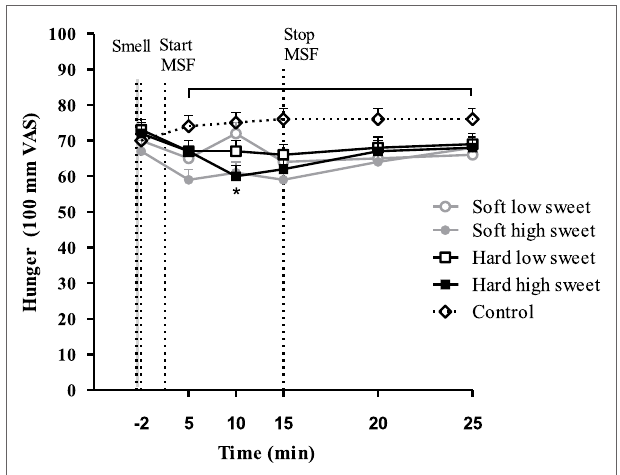
FigUre 12 | Estimated mean ± SEM post modified sham feeding (MSF) lunch intake (in grams) per model food type. No significant differences were